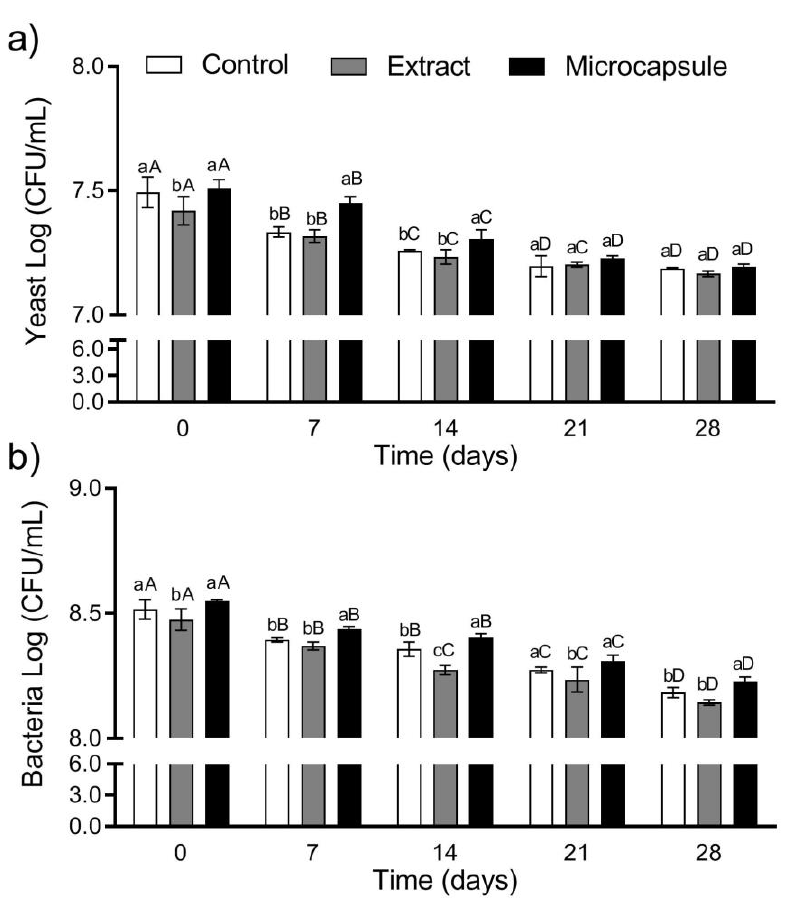
Figure 4. Microbial population during 28 days of storage at 4 ◦ C. ( a ) Yeast population. ( b ) L.A.B. pop- ulation. Different lowercase letters denote differences ( p < 0.05) among assays during the same time. Different capital letters denote differences ( p < 0.05) in the same assay at different times according to the Scott–Knott test. [Non-dairy matrix (N-DM): 1 Control—consists only of the fermented beverage (N-DM); 2 Extract—beverage (N-DM) with propolis extract (DPE); 3 Microcapsule—beverage (N-DM) with microencapsulated propolis (D.M.P.)].